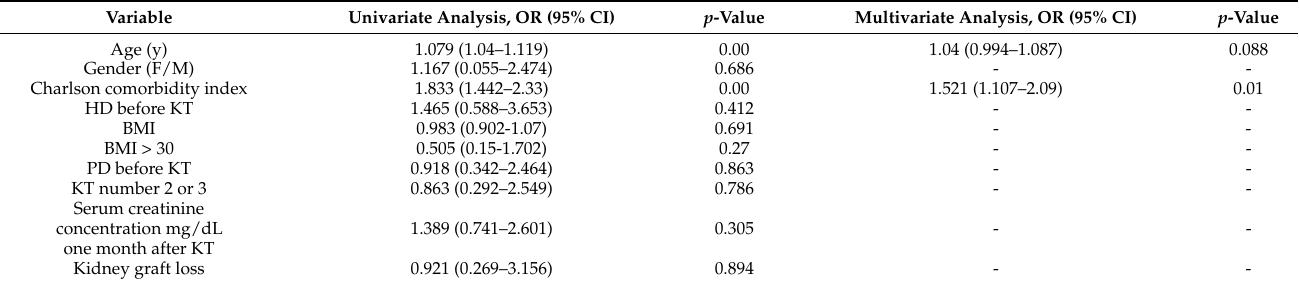
Table 4. Univariate and Multivariate Analysis of predictors of mortality after kidney